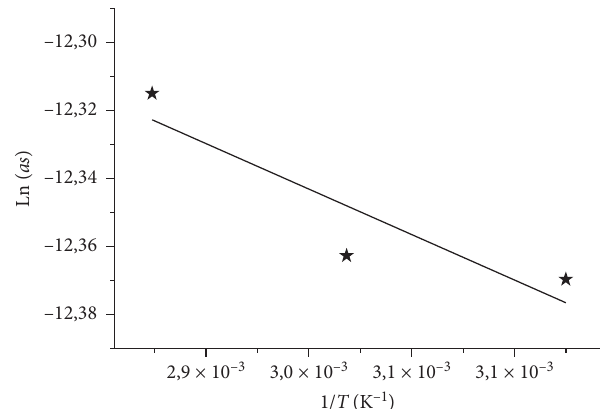
Figure 7: Logarithm variation of the initial speed in terms of 1/ T (K − 1